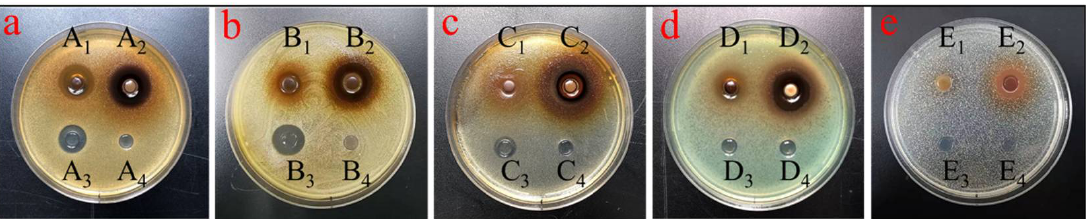
Figure 6. Effect diagram of inhibition zone diameter for S. aureus ( a ), S. epidermidis ( b ), E. coli ( c ), P. aeruginosa ( d ) and C. albicans ( e ). Crude extracts (A1, B1, C1, D1, E1); purified extracts (A2, B2, C2, D2, E2); kanamycin (A3, B3, C3, D3, E3); 50% methanol blank control (A4, B4, C4, D4, E4). Table 2. Zone of inhibition (ZOI) and minimum inhibition concentration (MIC) of crude extracts and purified extracts from Rosa setate x Rosa rugosa waste against tested strains.